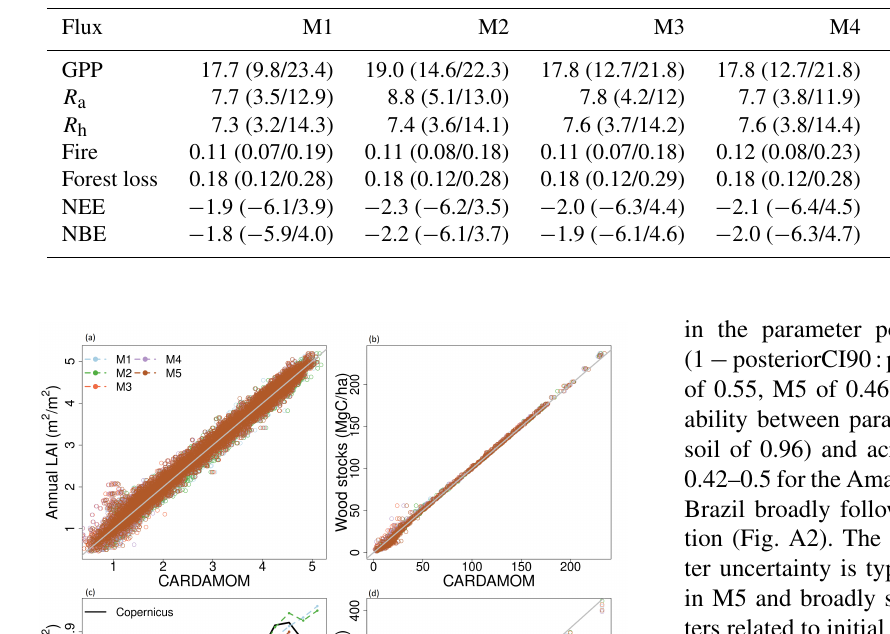
Table 2. Summary of Brazil-wide carbon budgets for each DALEC model and independent estimates. Fluxes are GPP, autotrophic res- piration ( R a ), heterotrophic respiration ( R h ), forest biomass loss, carbon emissions due to fire, NEE of CO 2 ( R a + R h − GPP) and NBE (NEE + fire). All units are in PgCyr − 1 . Values given as the median pixel-level estimates averaged across Brazil, while values in parentheses are averaged Brazil-wide for the 5% and 95% quantiles, i.e. assuming fully correlated uncertainties. Independent estimates are derived from FLUXCOM FluxSat v2 and Copernicus for GPP, GFW (for forest loss), Global Fire Emissions Database v4.1s for fire and CarbonTracker Europe for NBE. The time period of all data is 2001–2017.